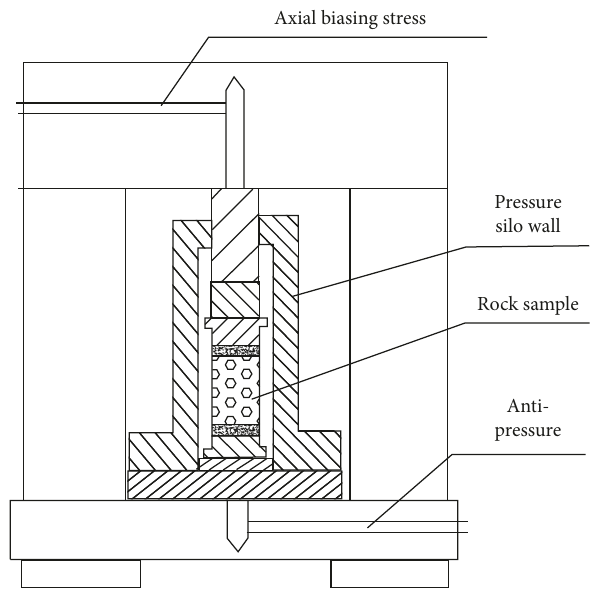
Figure 2: The experimental principles of the MTS815.02 electro- hydraulic servo rock mechanics system.